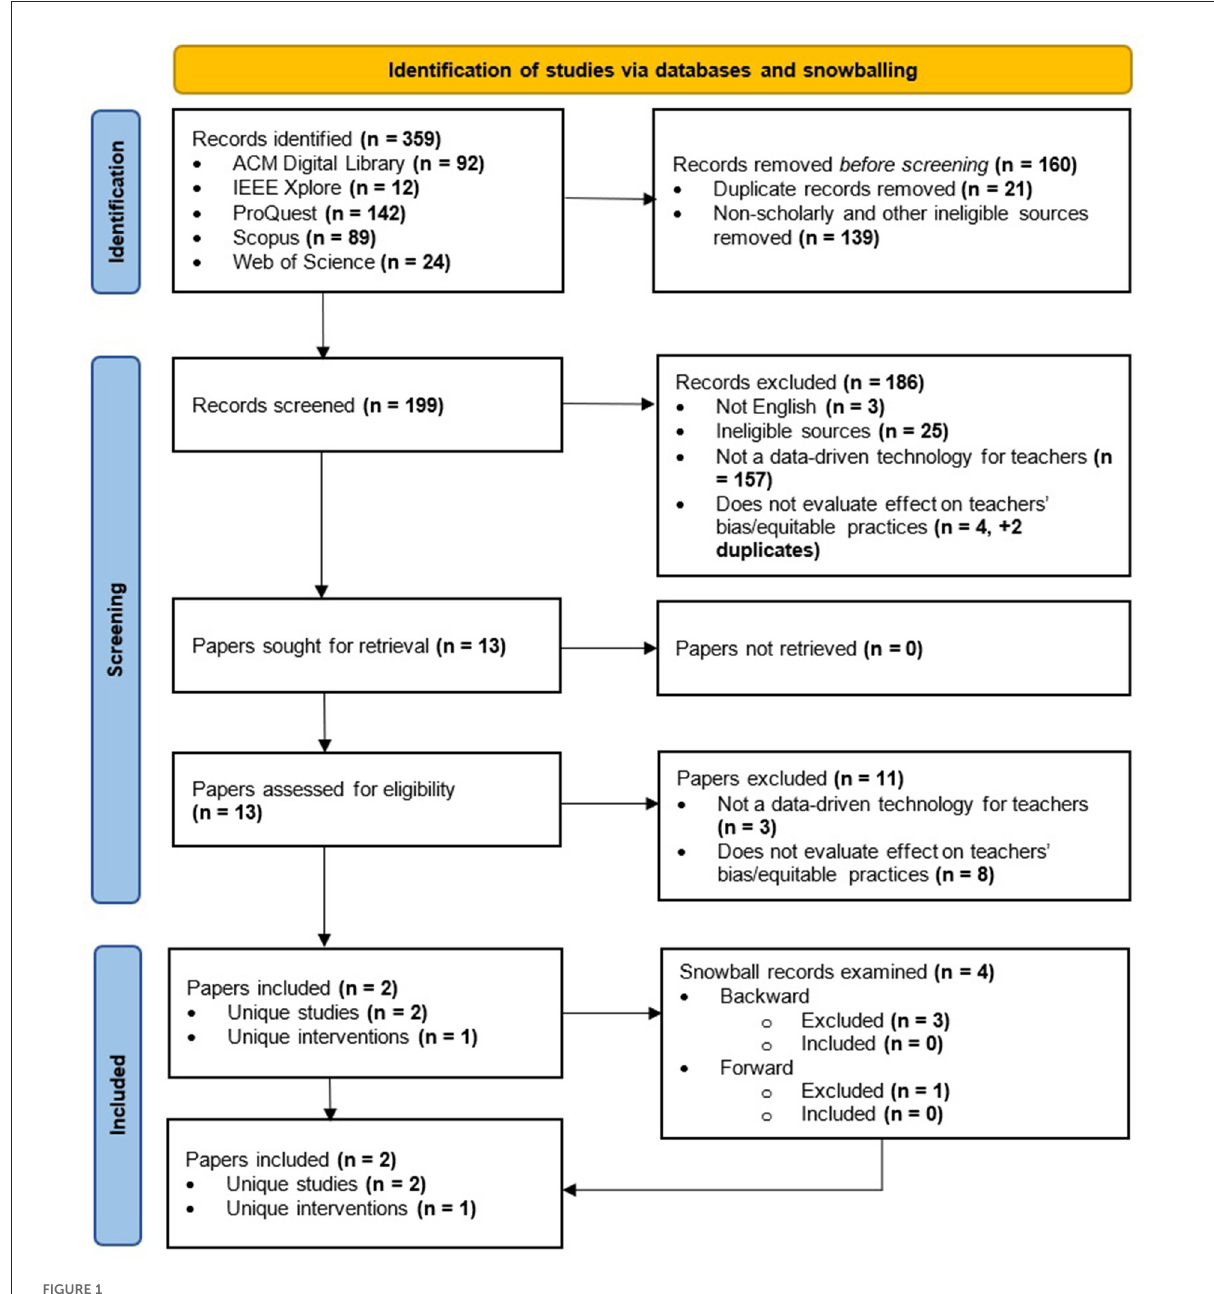
FIGURE1 Study selection flow